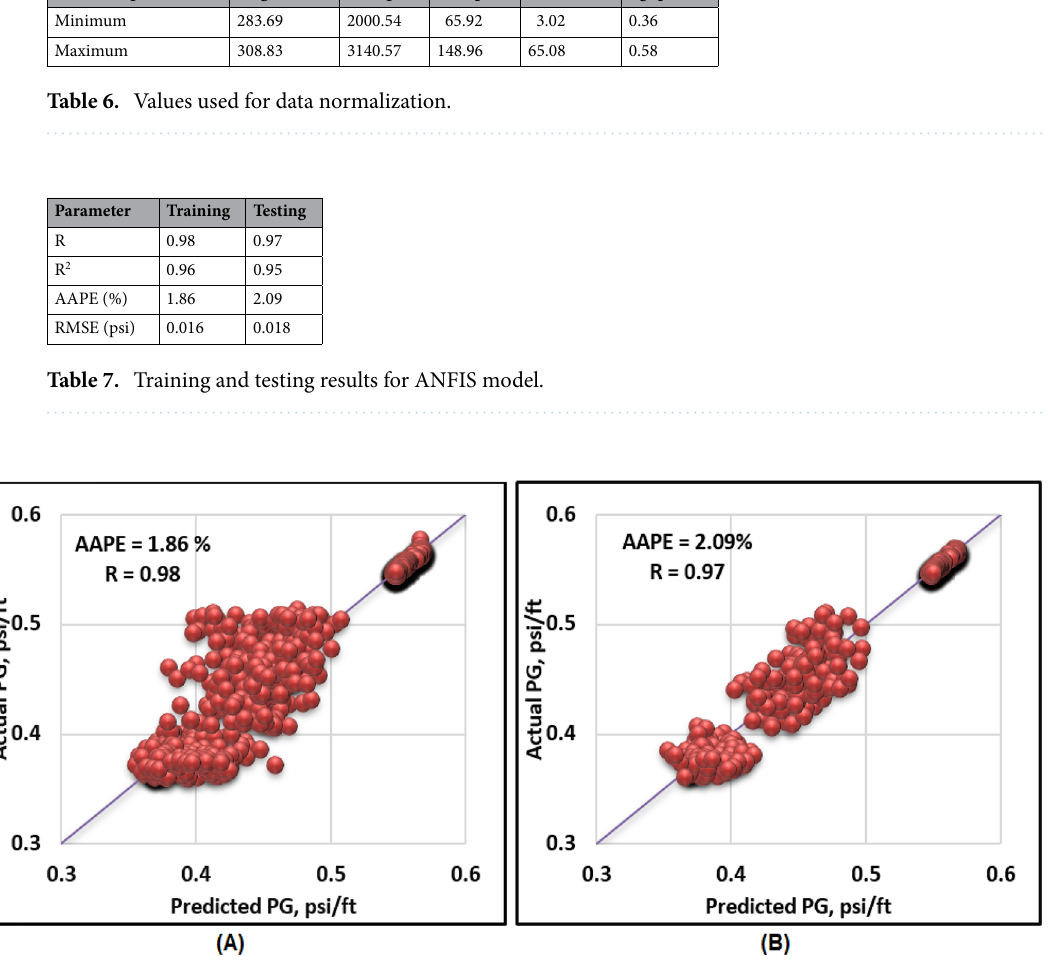
Figure 9. Cross-plots of the ANFIS model ( A ) training, and ( B )